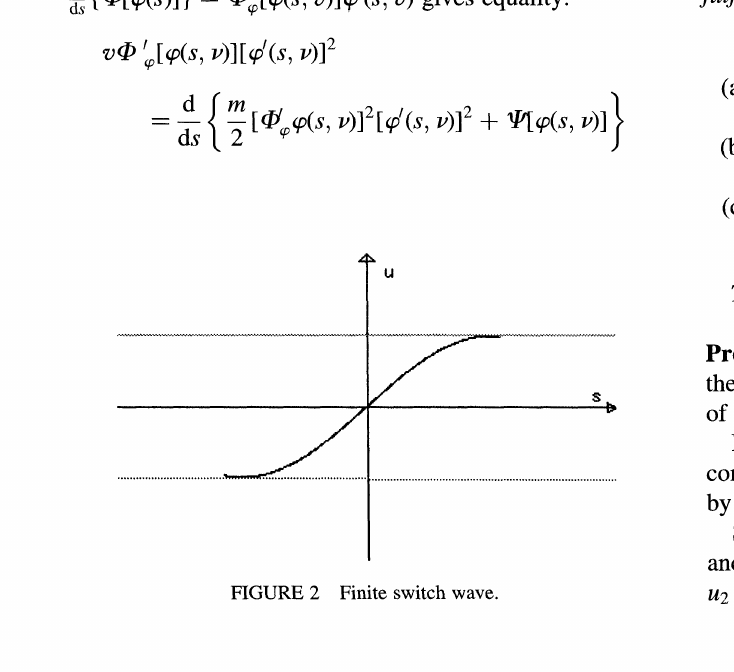
FIGURE 2 Finite switch